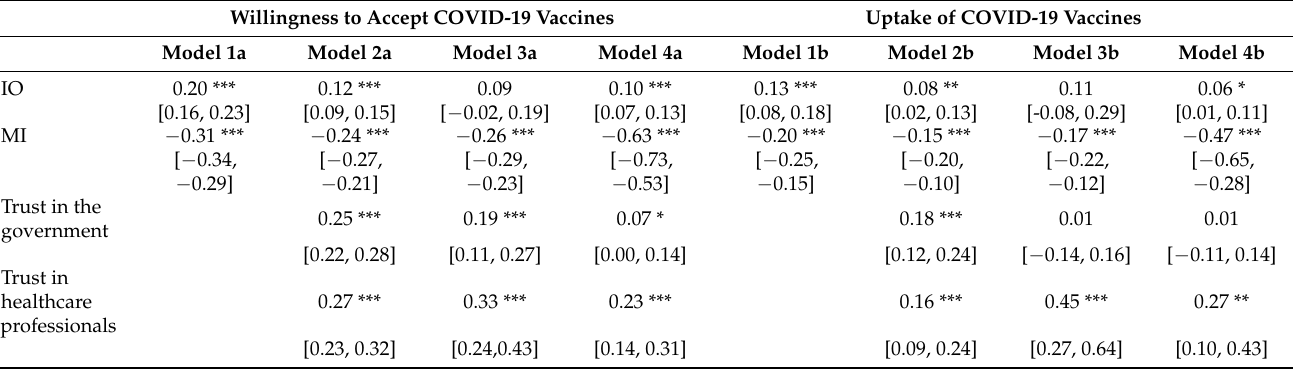
Table 3. Infodemic, institutional trust, and COVID-19 vaccine hesitancy and